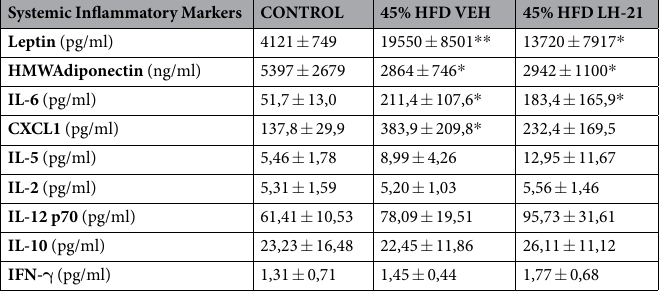
Table 1. Systemic inflammatory markers in obese pre-diabetic LH-21-treated mice. The levels of leptin and HMW adiponectin in plasma were measured with a commercial ELISA. A mouse pro-inflammatory panel kit was used for the quantitative determination of IFN- γ , IL-2, IL-5, IL-6, CXCL1, IL-10 and IL-12p70 by multi- array electrochemiluminescence detection technology. n = 8–10 mice each group. One-way ANOVA and Bonferroni’s post-test, * p < 0.05, ** p < 0.01 versus